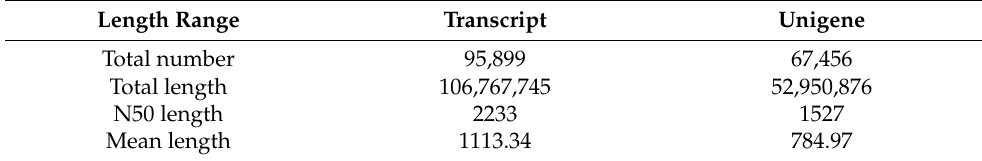
Table 1. Assembly result statistics (transcript/unigene).